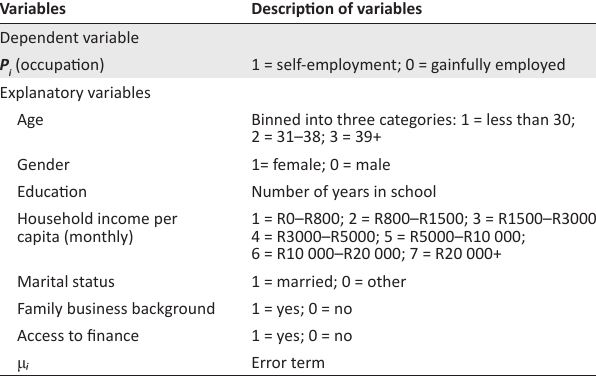
TABLE 1: Summary of variables used in the logistic